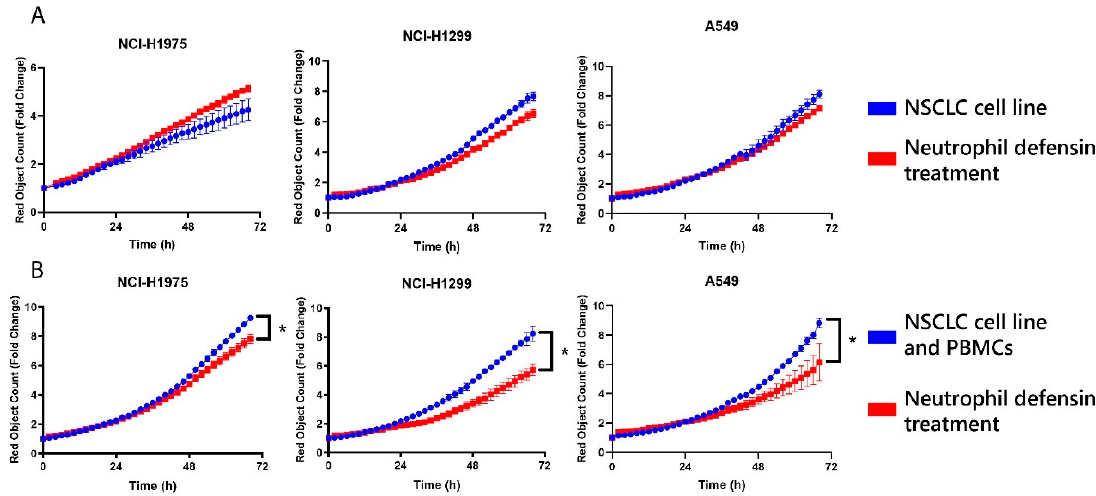
Figure 6. In-vitro analysis of tumor cell survival after addition of neutrophil defensin 1, 2 and 3. Tumor cell survival was determined by follow-up of the red object count using IncuCyte Zoom System. Data is represented as fold change compared to cell count before addition of treatment and the timelapse of the means ± the standard error of the mean (SEM) is displayed for each NSCLC cell line. ( A ) NSCLC cells (NCI-H1975, NCI-H1299, A549) were treated with neutrophil defensin 1, 2 and 3 (Red, 5 µ M) or phosphate-bu ff ered saline (PBS) (Blue, control) for 3 days. No concluding results can be made; ( B ) NSCLC cells (NCI-H1975, NCI-H1299, A549) were cocultured with peripheral blood mononuclear cells (PBMC) from three healthy donors and treated with neutrophil defensin 1, 2 and 3 (Red, 5 µ M) or PBS (Blue, control) for 3 days. Two replicates for every donor (three donors in total) were measured. Significant decrease (* p = 0.05) in tumor cell proliferation for all three NSCLC cell lines.